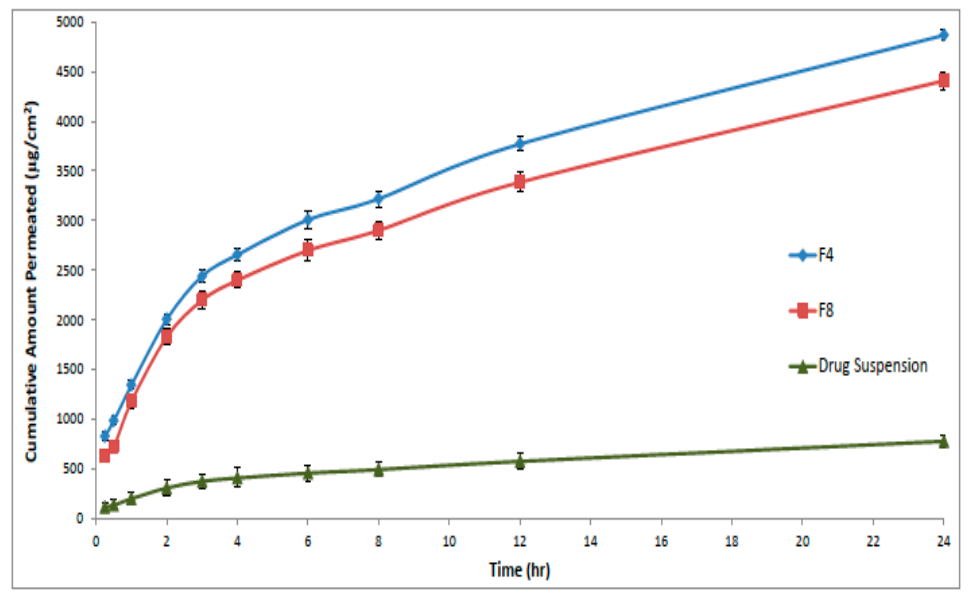
Table 2. Permeation data parameters.